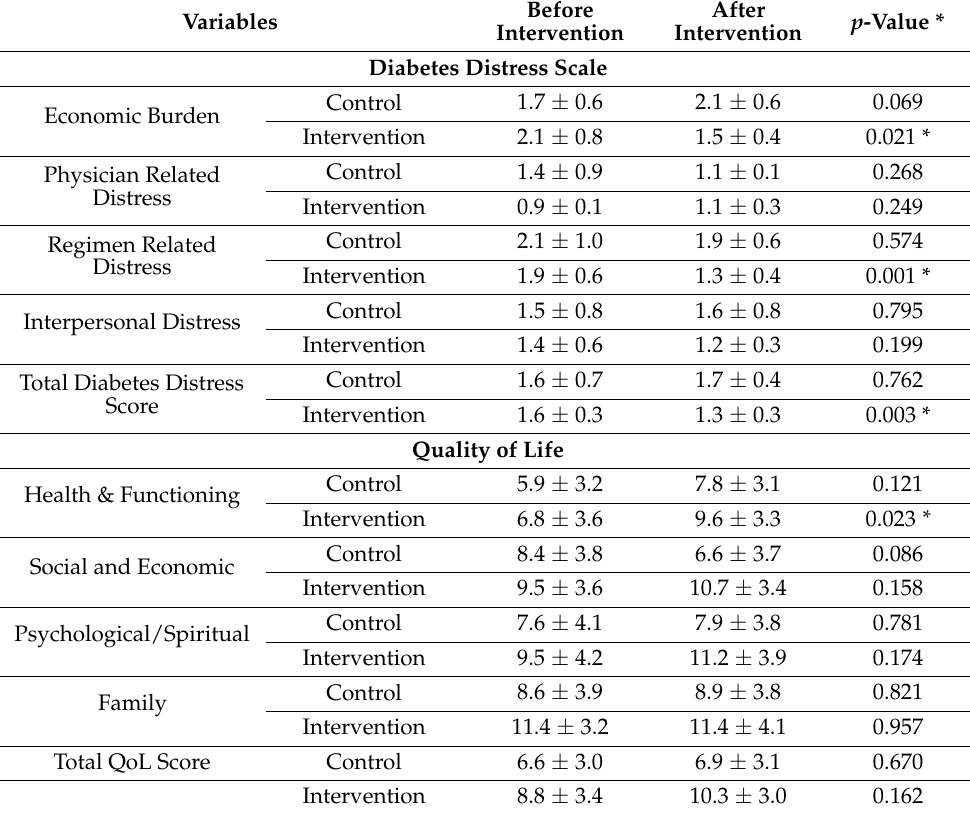
Table 3. Comparison of the quality of life (QoL) and Diabetes Distress Scale (DDS) score among the control and intervention groups after the